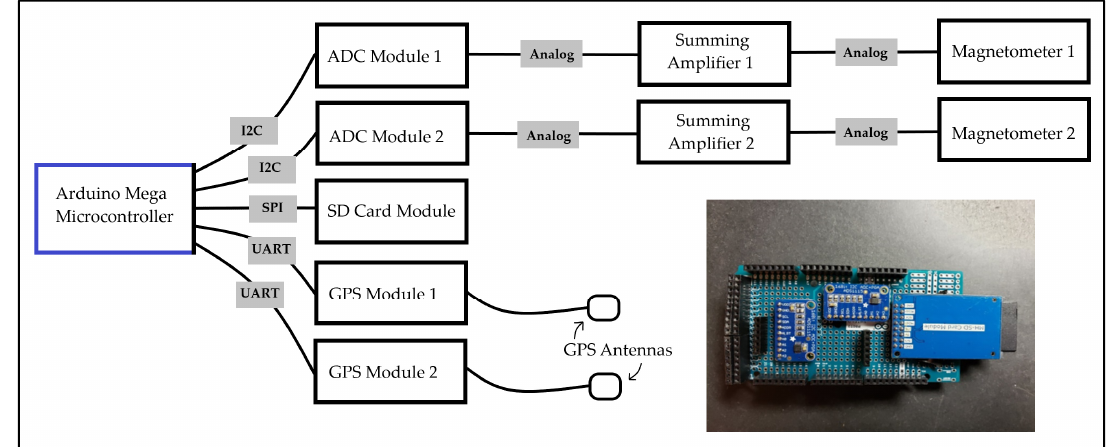
Figure 1. Connection types between components in the Arduino based data logging unit. The bottom right shows some of the components connected to the Arduino Mega.